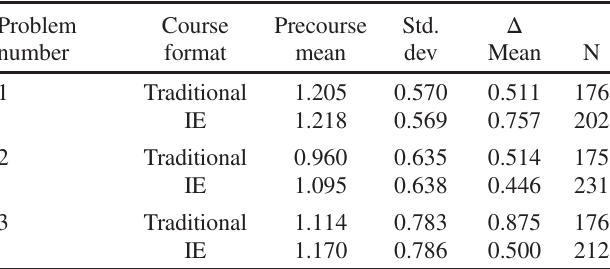
TABLE II. Precourse translation scores (and standard devia- tions) and increase in postcourse translation scores for sample of IE physics students matched to the traditional physics students on the precourse translation scores. ( Δ Mean indicates the average of the difference between each student ’ s pre and postcourse score.)